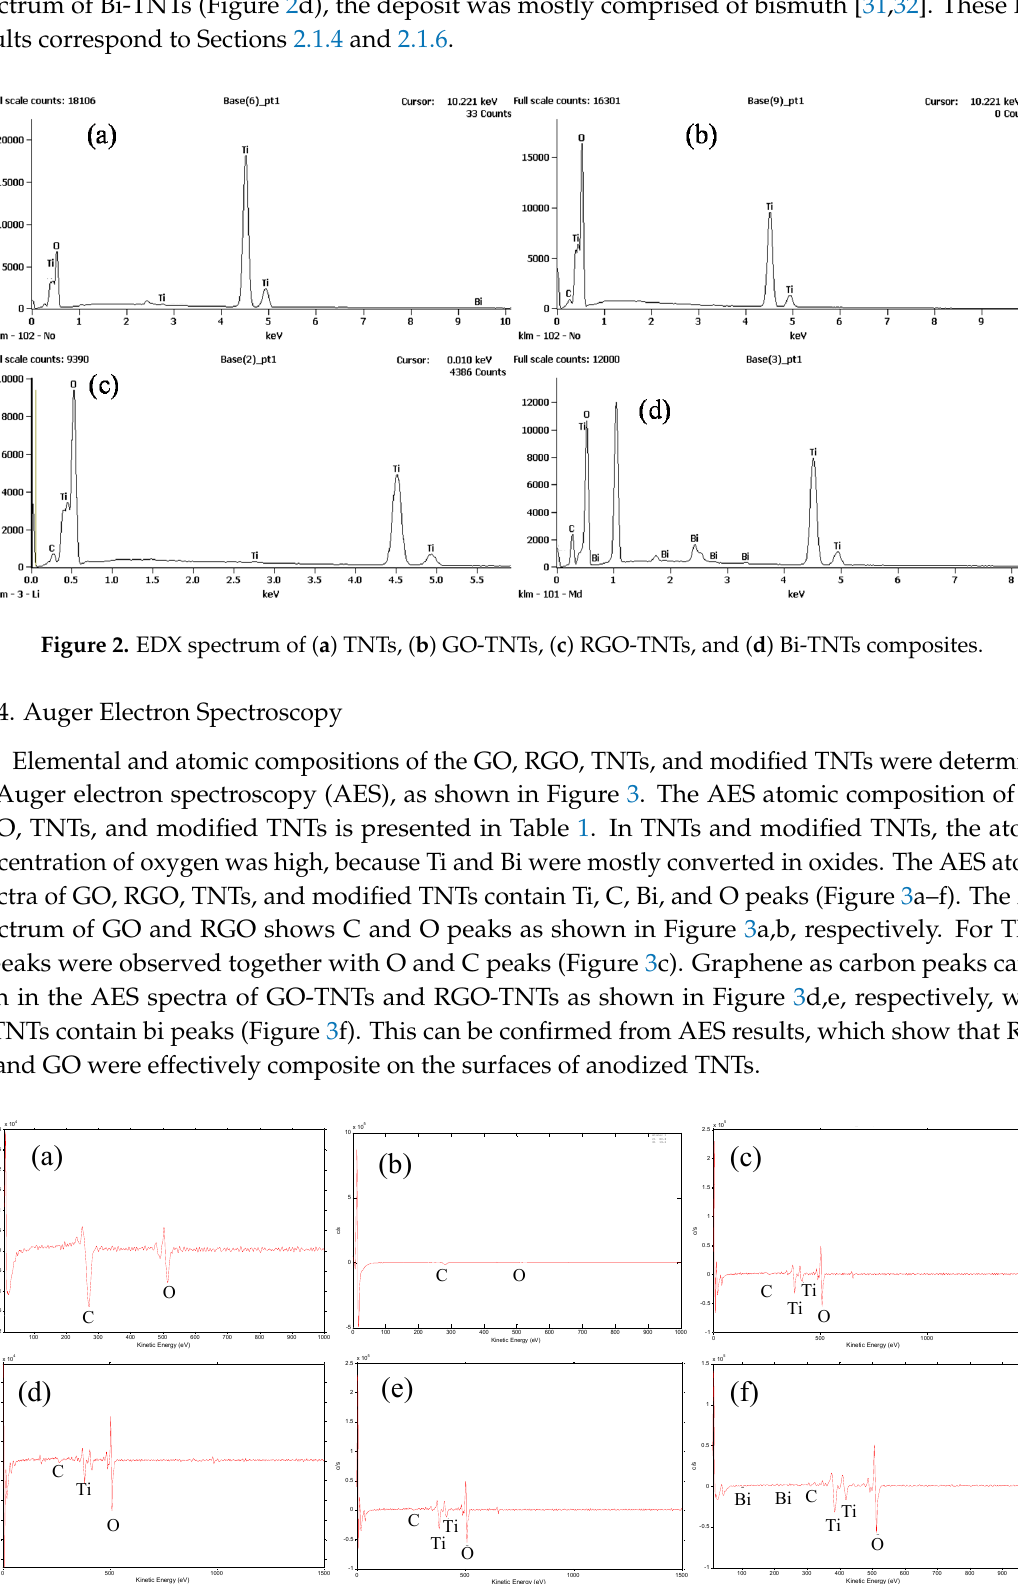
Figure 3. AES spectra of ( a ) GO, ( b ) RGO, ( c ) TNTs, ( d ) RGO ‐ TNTs, ( e ) GO ‐ TNTs, and ( f ) Bi ‐ TNTs composites.